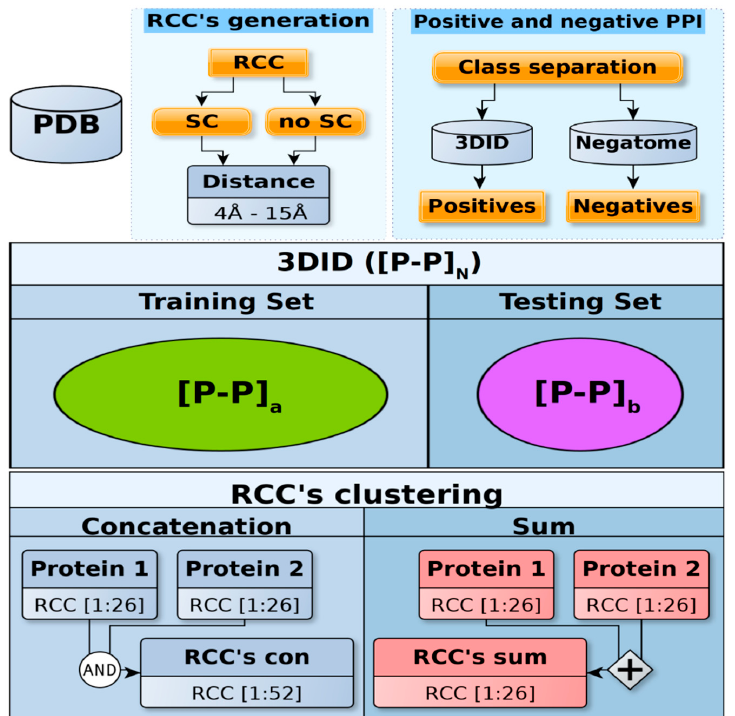
Figure 2. Dataset construction. Top panel: Every PDB reported as positive protein–protein interactions (PPI) in the 3DID database and as negative PPI in the Negatome database were processed to include (sidechain (SC)) or not include (no SC) the atoms of sidechains. A total of 12 different contact maps (contact distances 4–15 Å) were generated for each of these proteins and their residue cluster classes (RCCs) were calculated. Middle panel: The resulting numeric representations for all protein pairs were split into training and testing sets, which did not share the same positive PPI pair but did include the same PFAM domains. The procedure used to separate the positive PPI included in 3DID guaranteed that more instances were included in the training set than the testing set (see Methods). The positive PPI are represented in the figure as [P-P] N in the 3DID, [P-P] a for training, and [P-P] b for testing, where N = a + b and a > b . Due to the limited number of negative cases, we used the same negative set for both training and testing sets. Lower panel: The sum (26 features) or concatenation (52 features) for each RCC in every pair of proteins was obtained. Finally, every PPI numeric representation was normalized, standardized, or kept in its original form